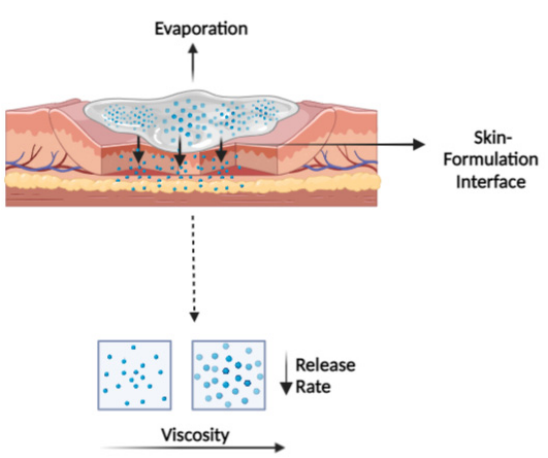
Figure 2. The graphical illustration of the interplay between the applied formulation and skin. The viscosity of topical semisolid products increased with the evaporation of volatile solvents, resulting in a more compact product microstructure at the skin–formulation interface. Thus, the release rate of APIs from the formulation was significantly reduced, indicating the product’s lower permeability and overall therapeutic efficacy.